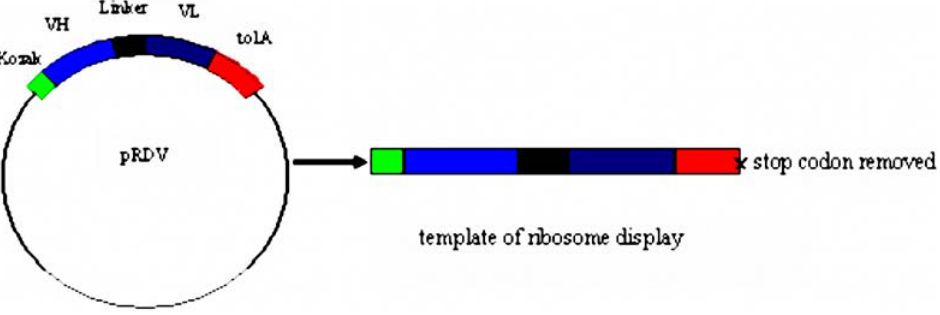
Figure 6. Construction of the template of ribosome display. In this generalized construct for ribosome display, the gene of interest is flanked by a 5 9 sequence with the T7 promoter (T7) and eukaryotic translation initiation (Kozak) sequence, and a tolA domain is attached at the 3 9 end as a spacer. The stop codon is removed to ensure stalling of the ribosome at the end of translation. X indicates removal of the stop codon.